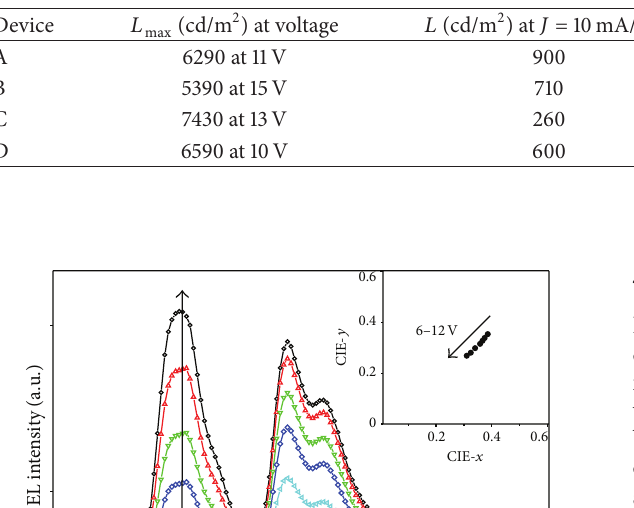
Table 1: Some detailed characteristics of four organic devices (different doping concentrations and ultra thin layer structures), including maximum luminance, CIE coordinates, and power efficiency.